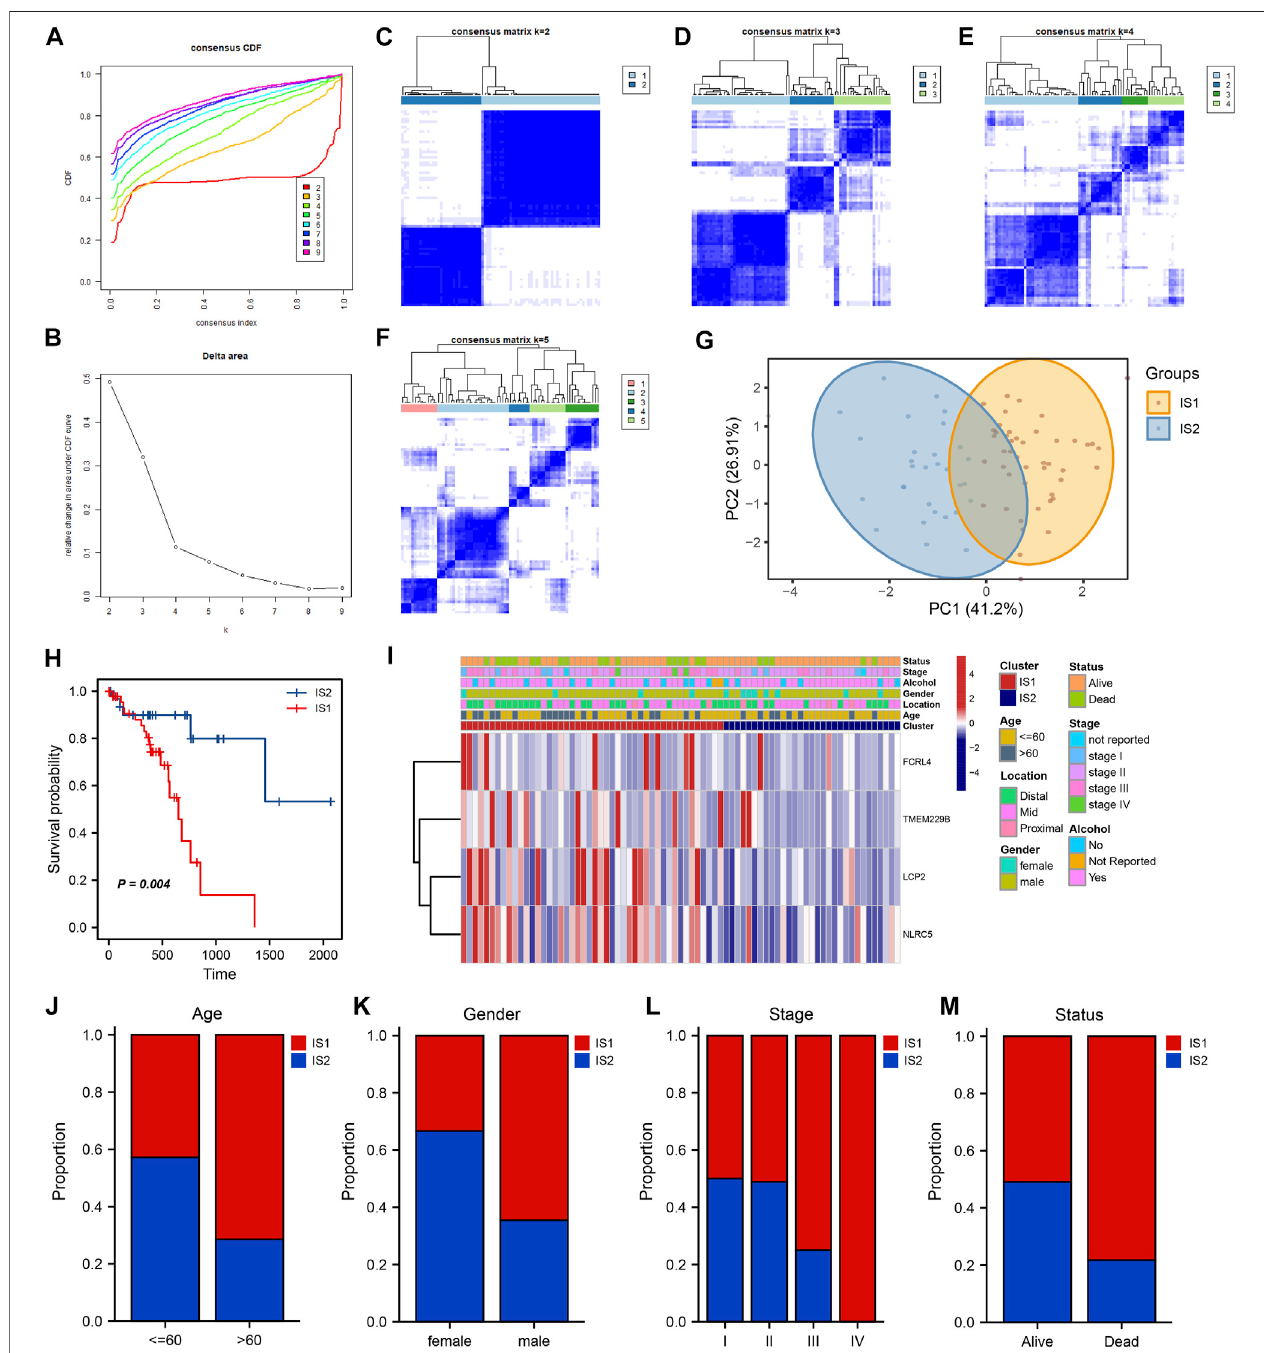
FIGURE 5 | Identi fi cation of potential ESCC immune subtypes. (A) Consensus clustering the cumulative distribution function curve for k = 2 to k = 9. (B) Relative change in area under the cumulative distribution function curve. (C – F) Clustering heatmap for k = 2 to k = 5. (G) PCA plot showing the distribution of IS1 and IS2. (H) Kaplan – Meier curve showing the OS of IS1 and IS2 in the TCGA cohort. (I) Heatmaps showing the relationship between potential ESCC antigens and clinical characteristics in different immune subtypes. (J – M) Distribution ratio of IS1 and IS2 across age, gender, stage and survival status in ESCC patients.